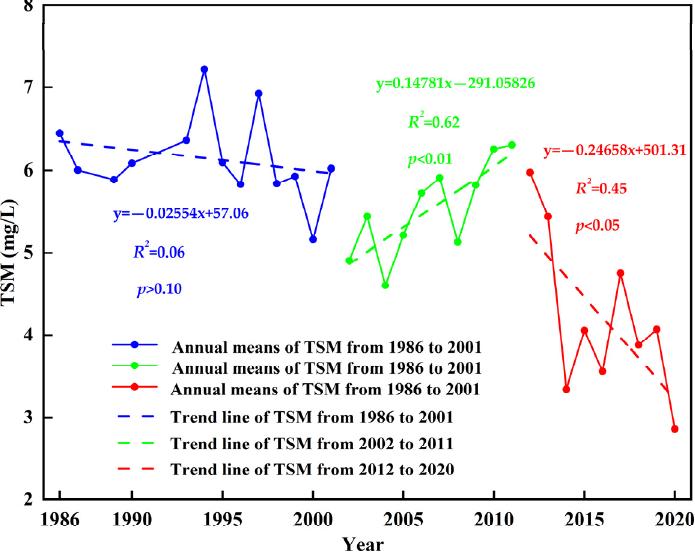
Figure 5. The yearly mean values of TSM across Lake Qinghai since 1986 by averaging all pixels.